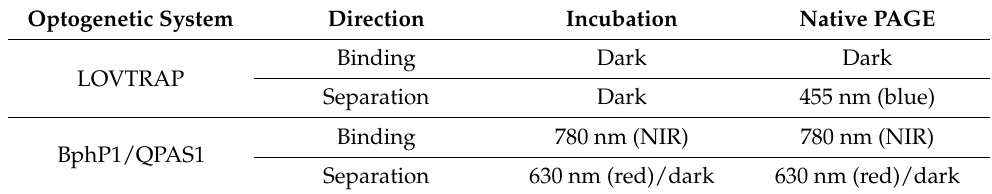
Table 3. Illumination conditions used in the in vitro binding assays and native PAGE experiments. Optogenetic